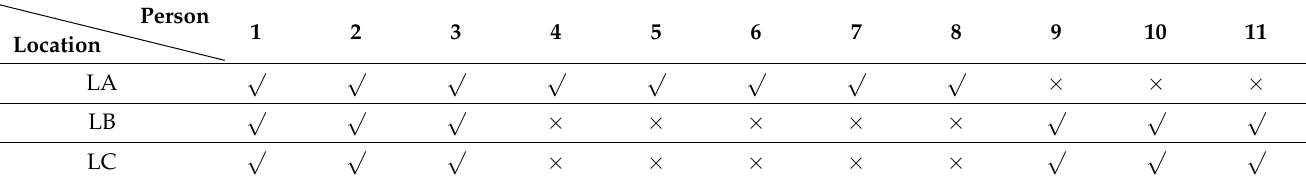
Table 1. The scanning single-voxel location list of each